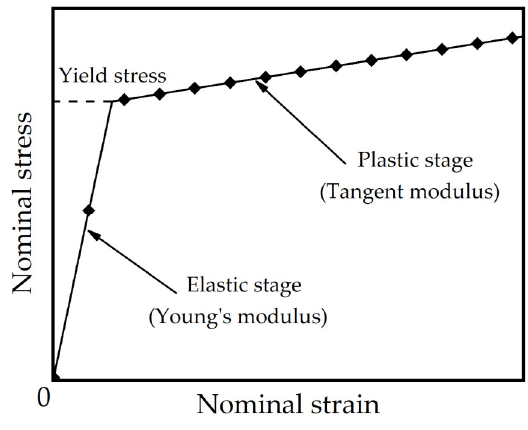
Figure 2. Schematic diagram of bi-linear elastic–plastic model. Table 1. Material parameters of vehicle and locating structure.